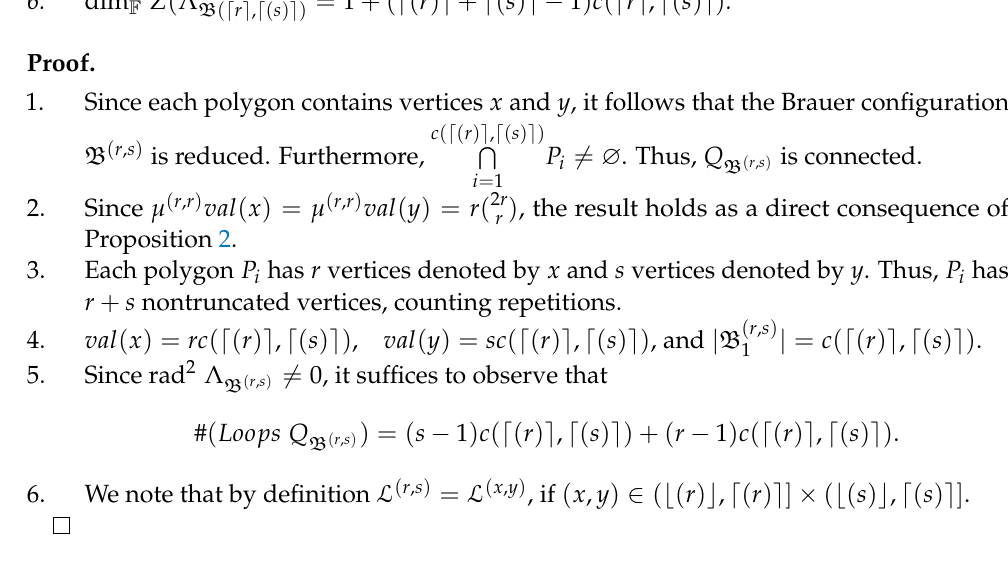
Figure 3. Example of a Brauer quiver associated with a Brauer configuration B ( r , s ) . The symbol c x ( c y ) denotes a set of loops c x j